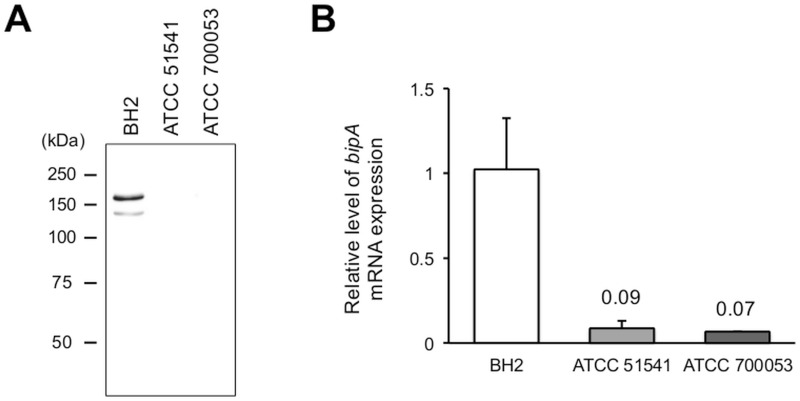
Lack of BipA protein and transcript expression in Bordetella holmesii ATCC strains.(A) B. holmesii BH2, ATCC51541, and ATCC700053 were cultured for 4 days on BG agar. Total protein (2 μg) was subjected to immunoblot analysis with anti-BipA antisera. (B) After culturing for 3 days on BG agar, total RNA was isolated, reverse transcribed into cDNA, and then analyzed by qRT-PCR analysis. Relative bipA transcript levels were calculated using the ΔΔCt method and were normalized to those of recA. The recA transcript was used as an internal control for each sample. Data are presented as fold-changes in expression compared to those observed in BH2. The means ± standard deviations of results obtained from 3 separate experiments are shown.